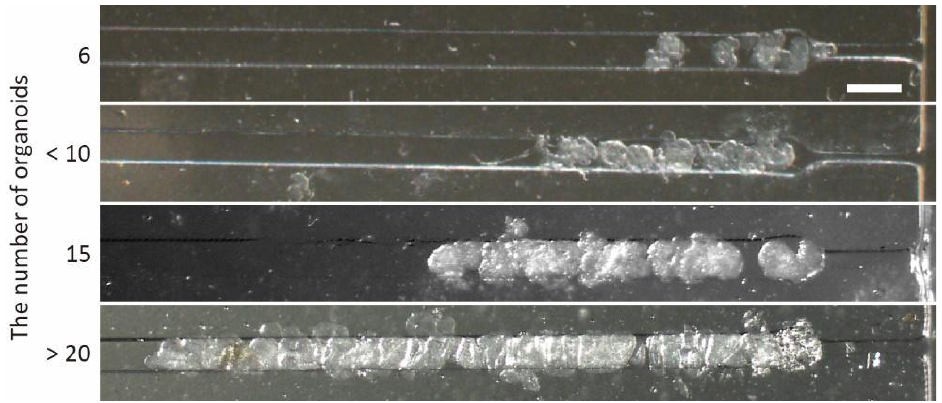
Figure 5. Trapped organoids at the trapping region of microfluidic devices. Scale bar is 200 µm.